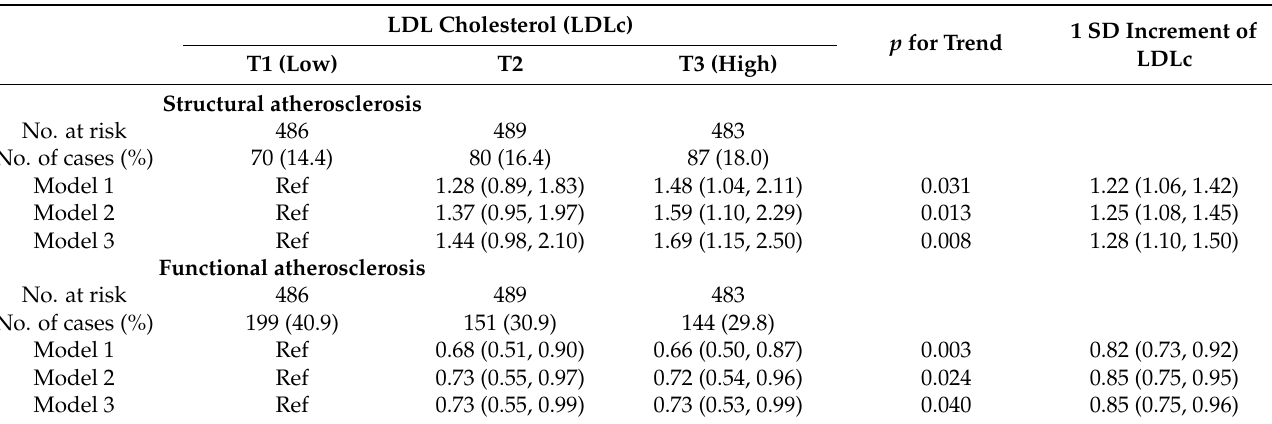
Table 3. Associations between low-density lipoprotein cholesterol and both structural and func- tional